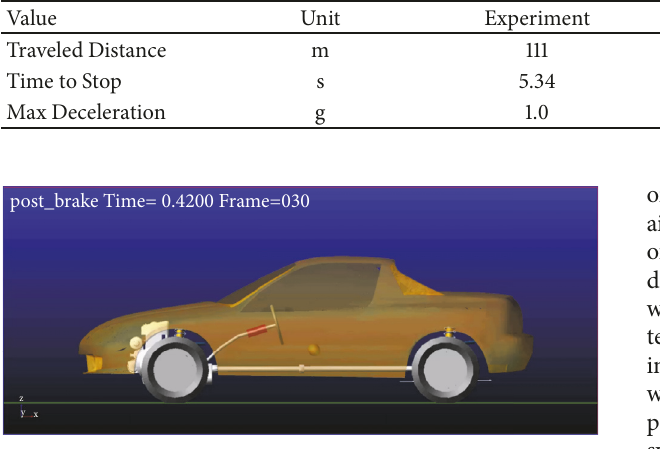
Figure 19: MSC.Adams/Car model used in the